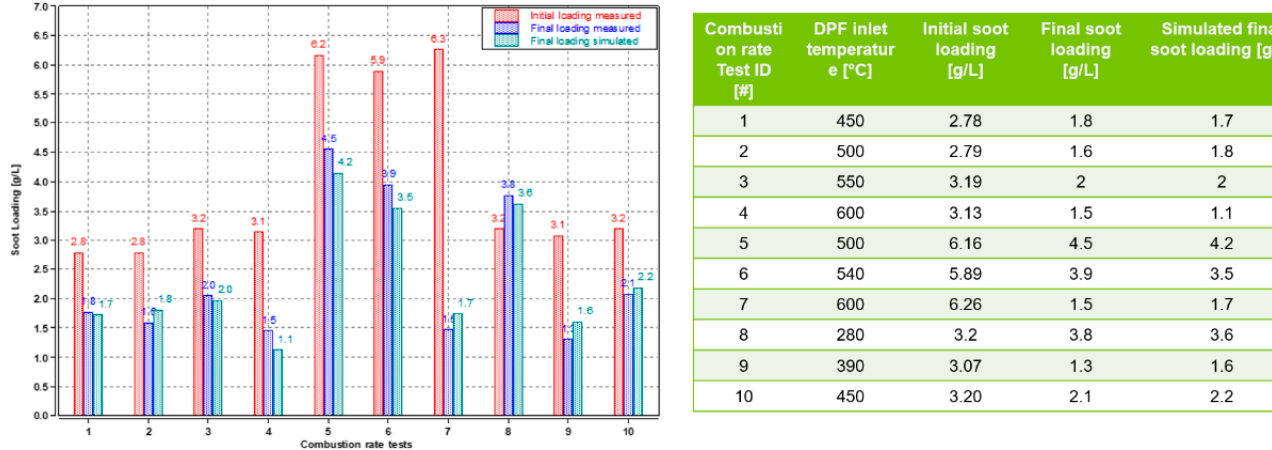
Figure 14. DPF Combustion rate simulated